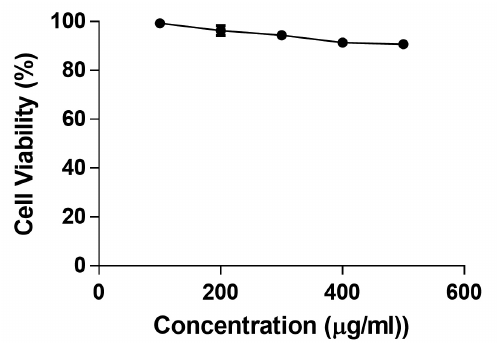
Fig. 4. The effect of A. suaveolens on 3T3-L1 cell line viability was analysed by MTT assay and the test compound didn’t show high toxicity and IC50 couldn’t be identified at given concentrations.